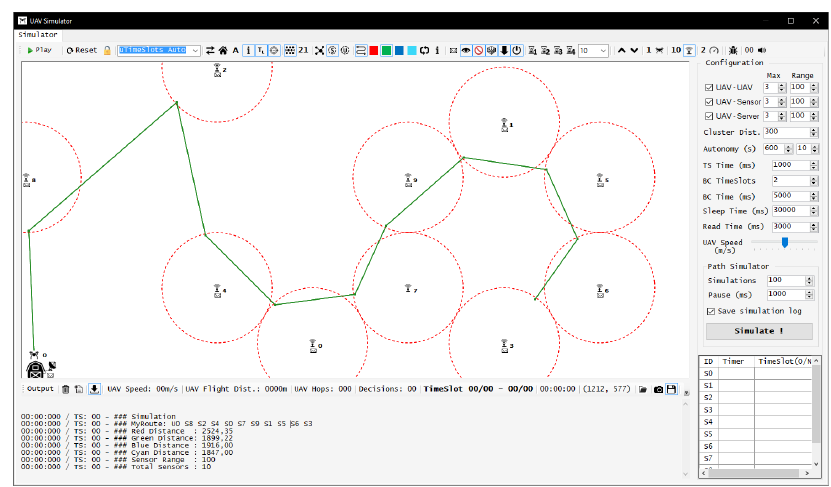
Figure 12. UAV Simulator main interface presenting the UAV’s path between the